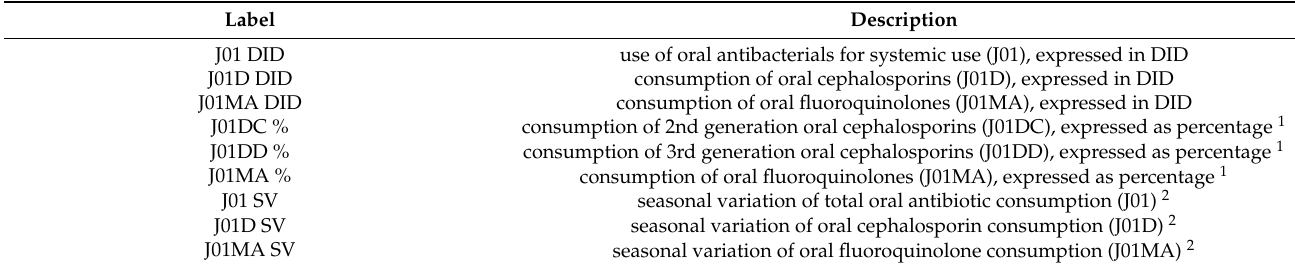
Table 1. Drug-specific quality indicators for oral ambulatory antibiotic use [21,22].